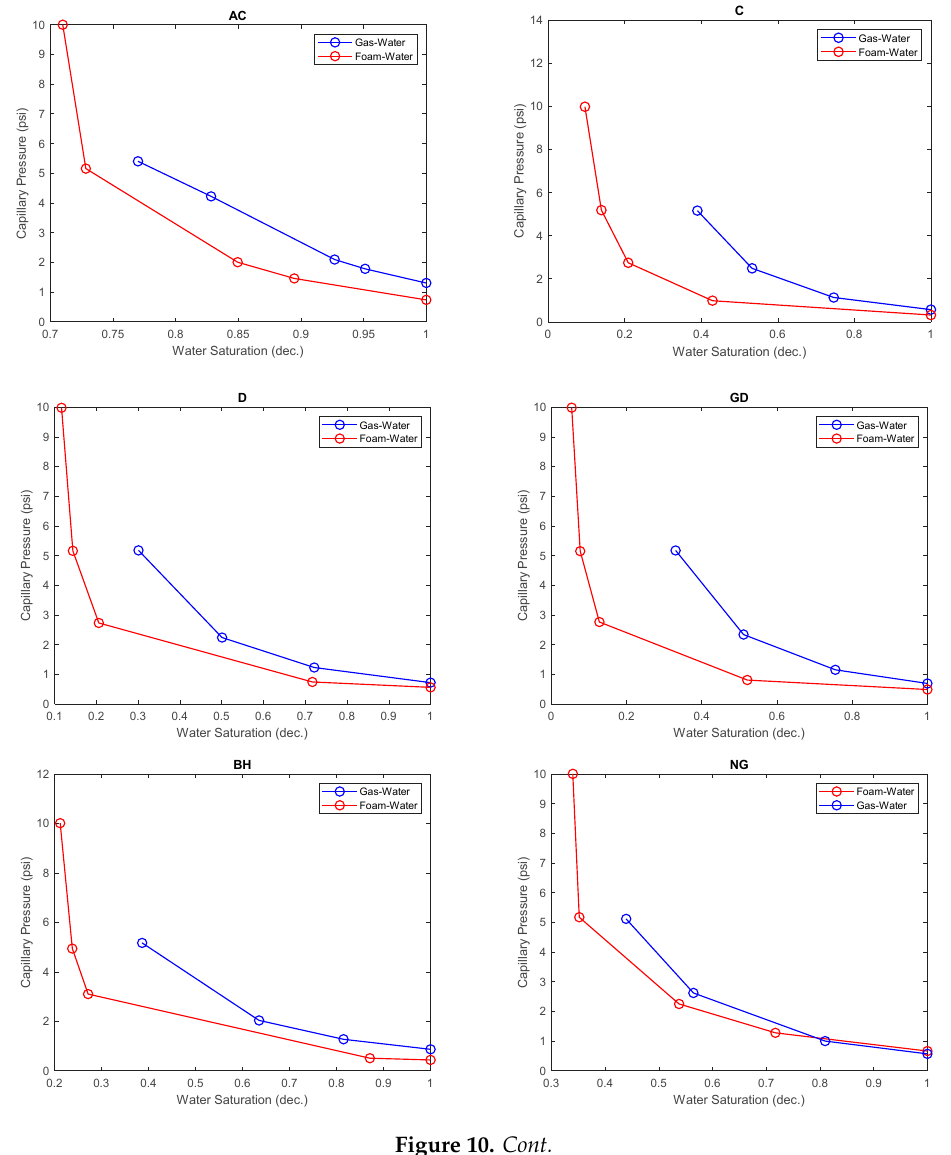
Figure 10. Comparison of the capillary pressure curves for foam–water and gas–water in different rock